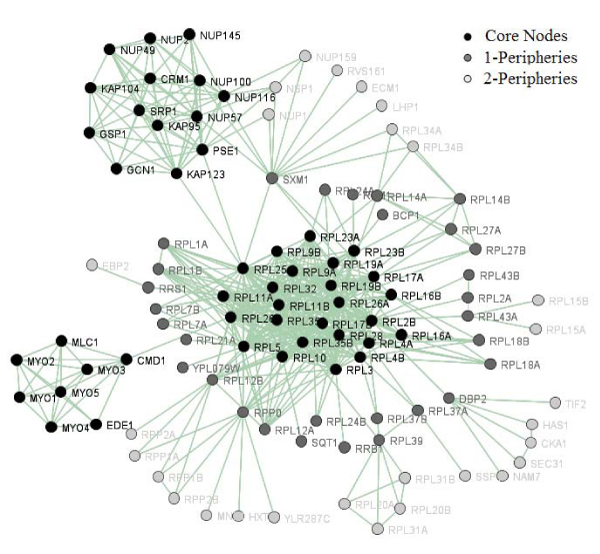
The peripheries of the largest k-plex core in YPIN. Among the 1-peripheries of largest k-plex core, CMD1, PSE1 and KAP123 are three core-member peripheries of this largest k-plex core. SXM1, DBP2, RPL43A are the multiple core peripheries of the largest kplex core. Graph is produced using Biolayout [47].